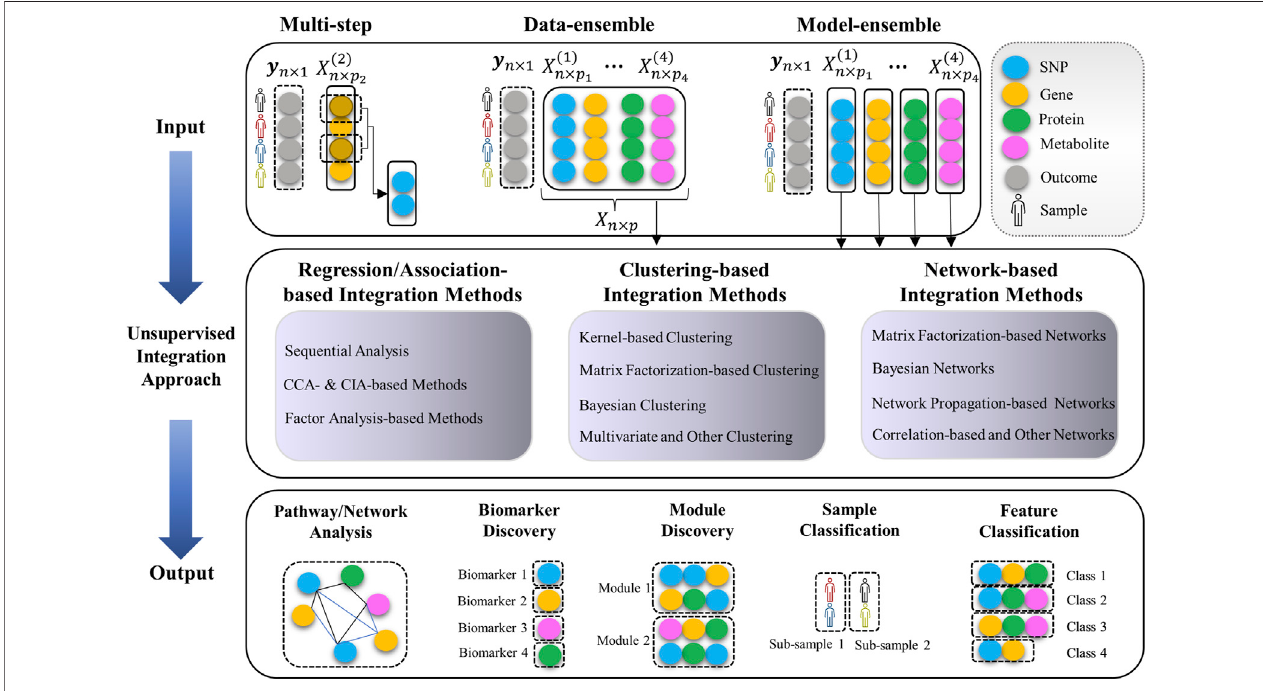
FIGURE 2 | Unsupervised multi-omics data integration pipeline (input data, integration methods, and output). Data-ensemble methods concatenate the multi- Omics data from different molecular layers to a single matrix as the input data. Model-ensemble methods analyze each Omics data independently and then ensemble/ fusetheresultstoconstructanintegrativeanalysis.A “ module ” isacombinationofdifferentOmicsmarkerswithsimilarfunctionsorassociationsregardingtheunderlying outcome. A “ class ” is a group of Omics markers that have the same effect on the outcome. A “ sub-sample ” is a group of biological samples (e.g., human, animal, plant) with the same behavior regarding the underlying outcome. X and indicate the features and outcome variable, respectively. n and p j show the sample size and the number of the Omics features in the j th Omics type.